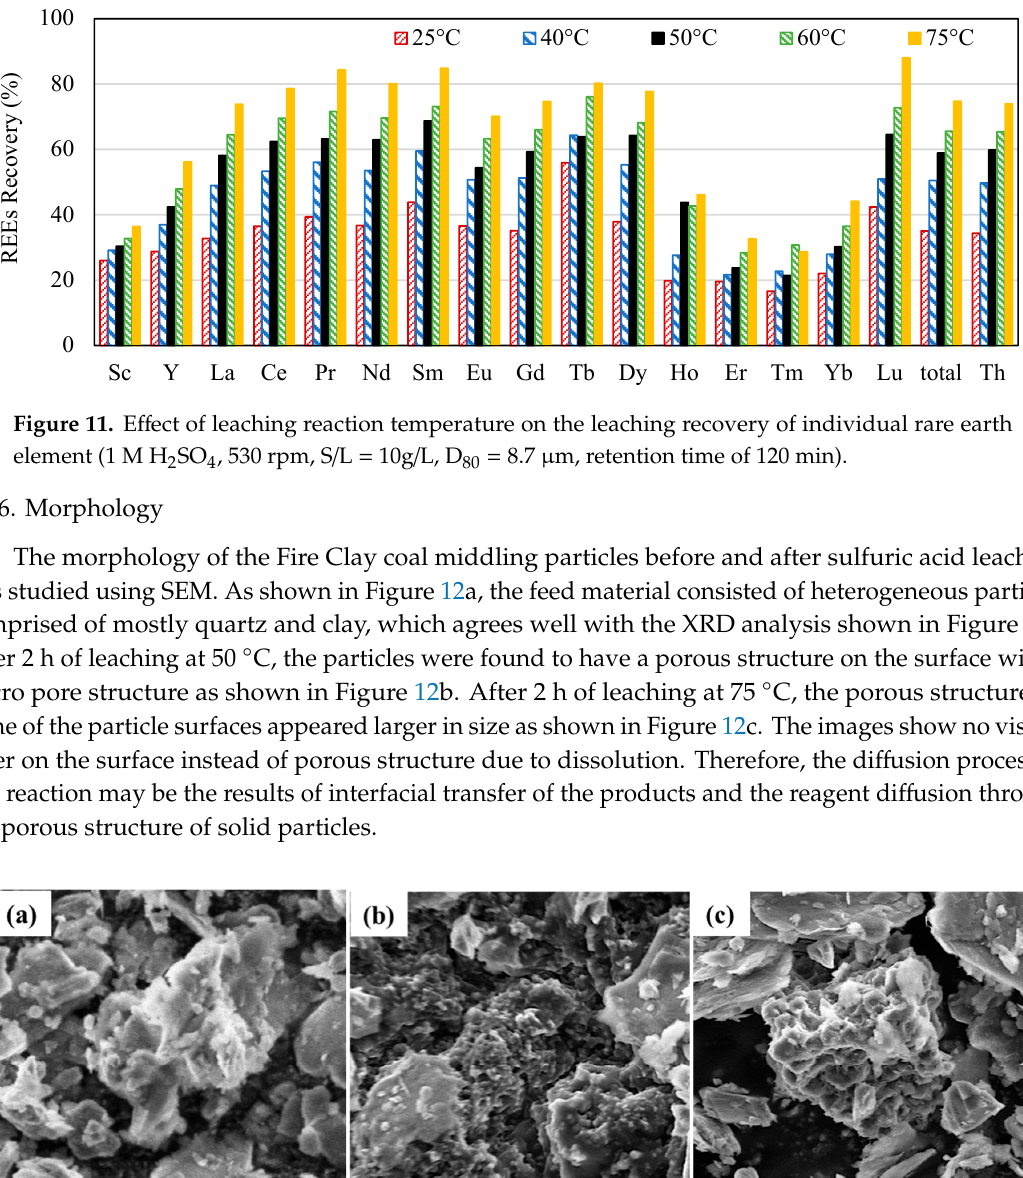
contained in the Fire Clay coal middling (1 M H 2 SO 4 , 530 rpm, S/L = 10g/L, D 80 = 8.7 μ m).